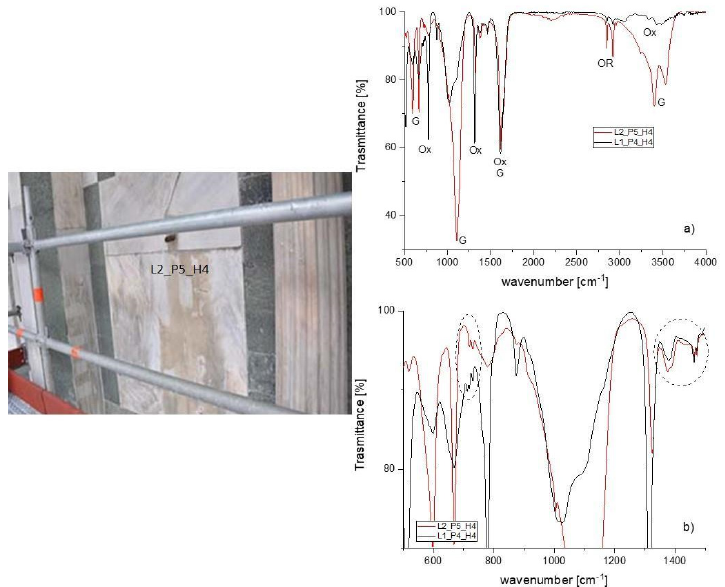
Figure 6. Photographic documentation of dark brown patinas on marble. FTIR spectra of two samples are reported showing the presence of: ( a ) Ox, calcium oxalate; G, gypsum; OR, organic compound, microcrystalline wax. ( b ) Detail of the spectra between 500 to 1500 cm − 1 : the dashed circles highlight the vibrational bands of microcrystalline wax.